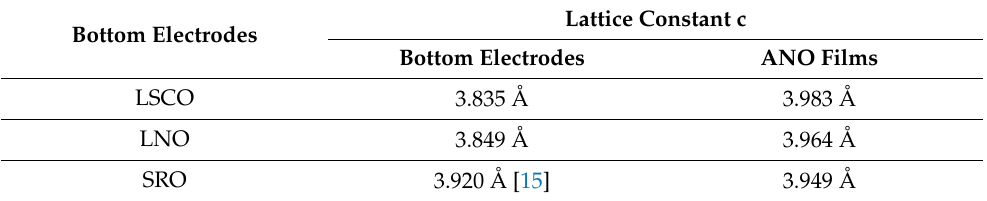
Table 1. Out-of-plane lattice constant c of LSCO, LNO and SRO bottom electrodes and ANO